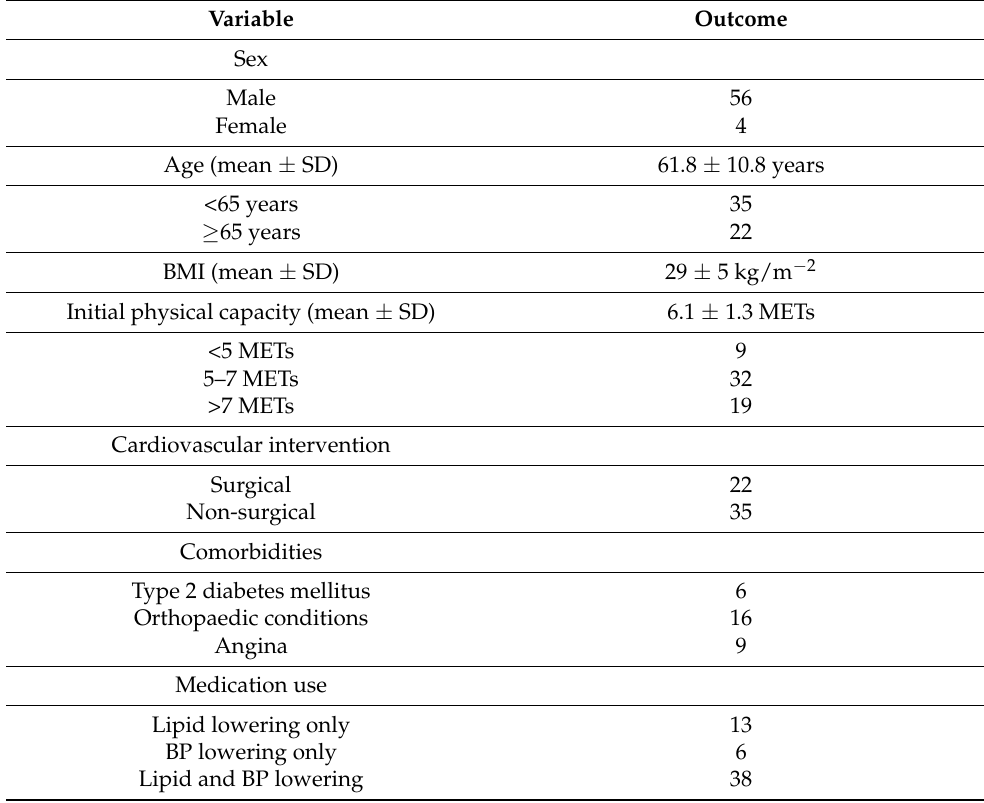
Table 1. Baseline demographic information for included